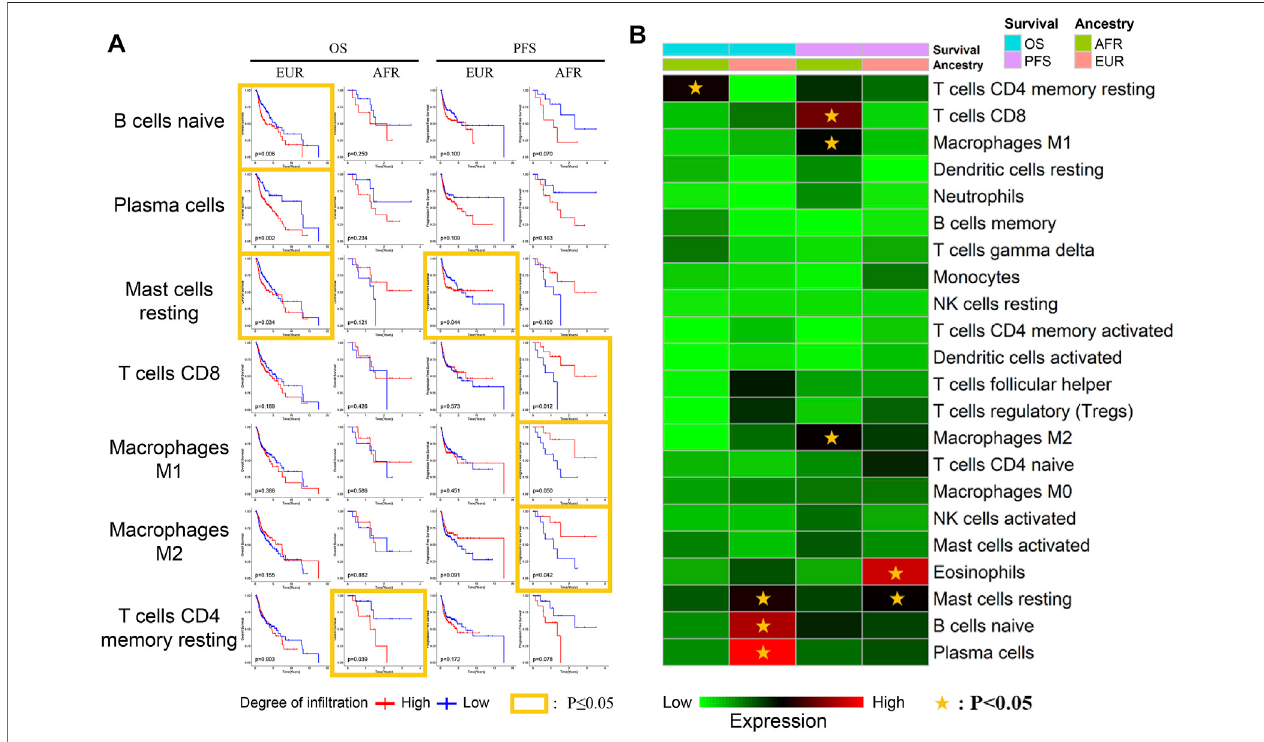
FIGURE 8 | Relationship between immune cells and survival with different genetic ancestries. (A) The relationship between immune cell in fi ltration and survival in EUR and AFR OSCC patients. (B) P-value heat map of the relationship between immune cell in fi ltration and survival in EUR and AFR OSCC patients.